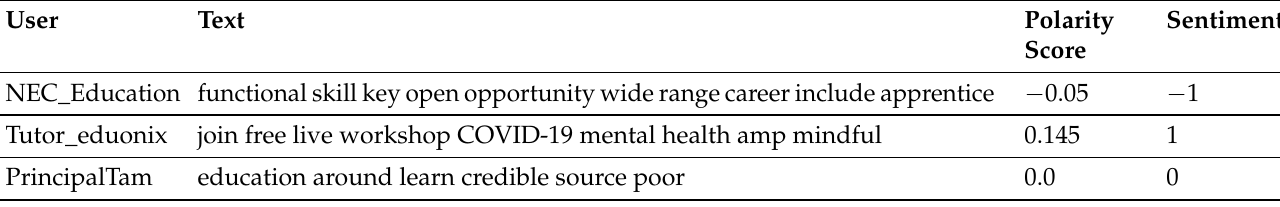
Table 3. Sentiment score assigned by